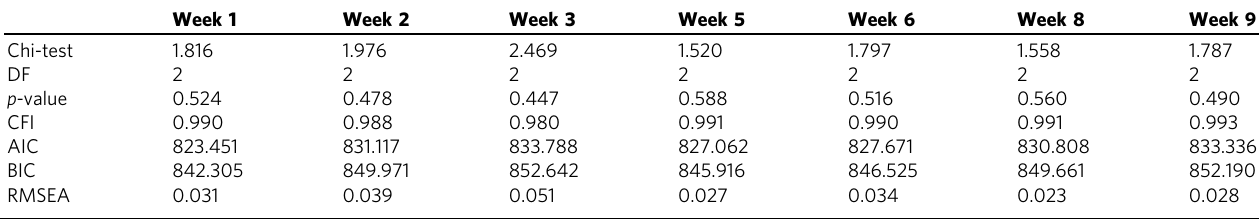
Table 1 The goodness of fi t indices for the SEM model with bootstrapping for each